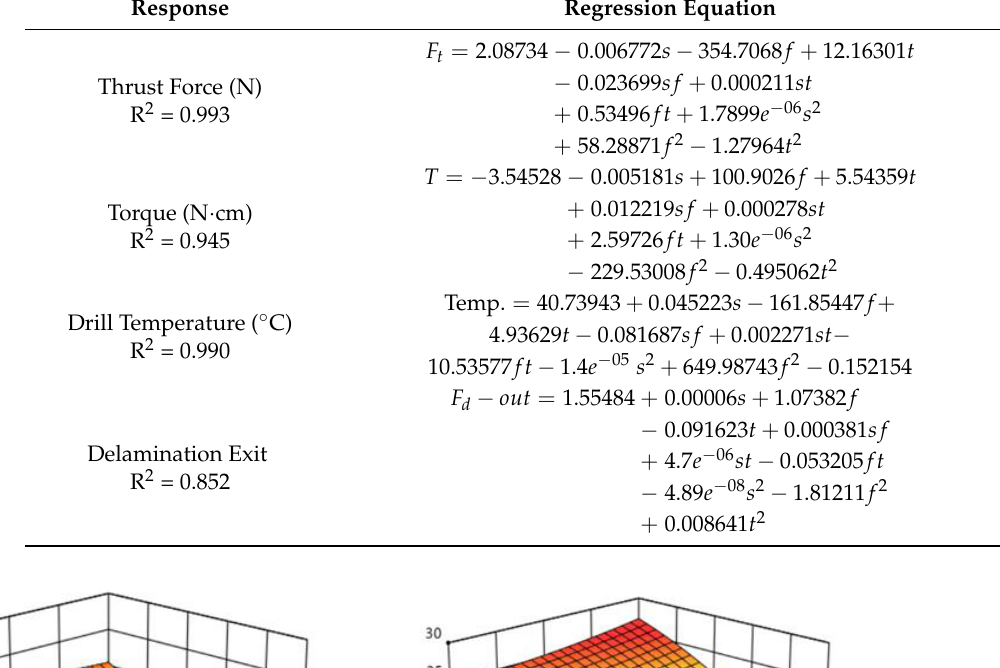
Table 6. Nonlinear regression model for machinability responses.